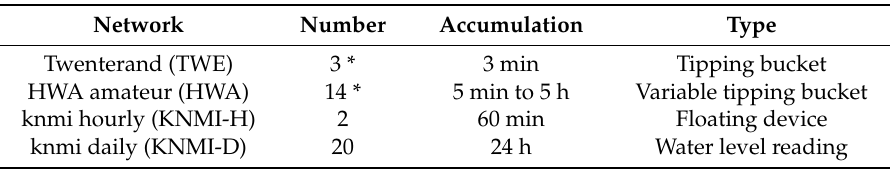
Table 1. Available rain gauges in the study area and their characteristics. Network Number Accumulation Type Twenterand (TWE) 3 * 3 min Tipping bucket HWA amateur (HWA) 14 * 5 min to 5 h Variable tipping bucket knmi hourly (KNMI-H) 2 60 min Floating device knmi daily (KNMI-D) 20 24 h Water level